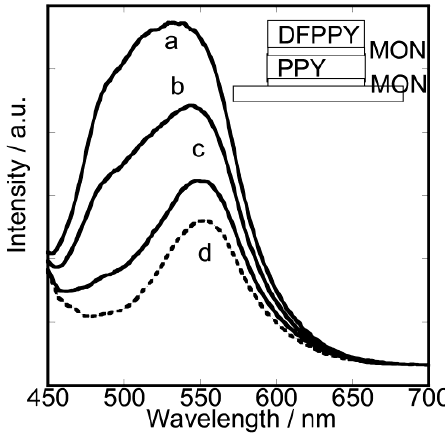
Figure 5. The luminescence spectra from the hetero-layered hybrid LB films of {DFPPY/MON/PPY/MON}. The excitation wavelength was 430 nm. The vertical axis denotes the intensity of luminescence at an arbitrary unit. a: in vacuum, b: 4 kPa, c: 27 kPa, d: 101.3 kPa of oxygen pressure (modified from reference